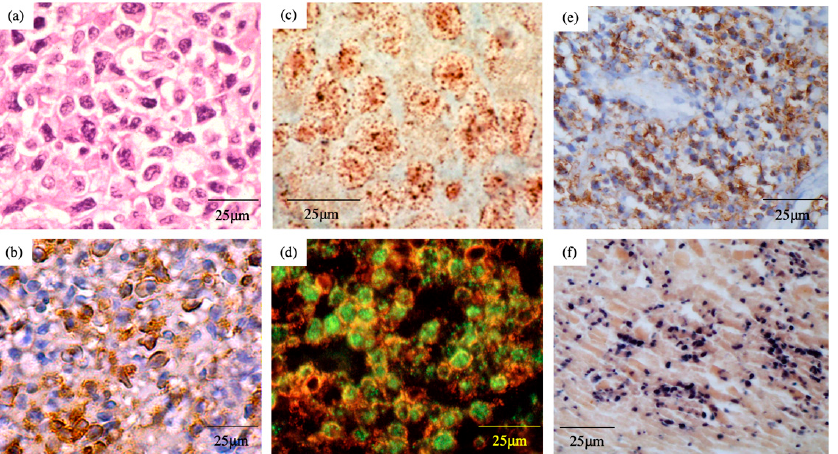
Figure 2. Pathological findings of extranodal NK/T-cell lymphoma, nasal type. ( a ) Hematoxylin and eosin staining; ( b ) immunohistochemical staining of CD56; ( c ) in situ hybridization of EBV DNA; ( d ) double fluorescence staining with CD2 (red) and EBV-encoded nuclear antigen (EBNA) 1 (green); ( e ) immunohistochemical staining of EBV-encoded latent membrane protein (LMP) 1; ( f ) In situ hybridization of EBV-encoded small nuclear early region (EBER) 1.